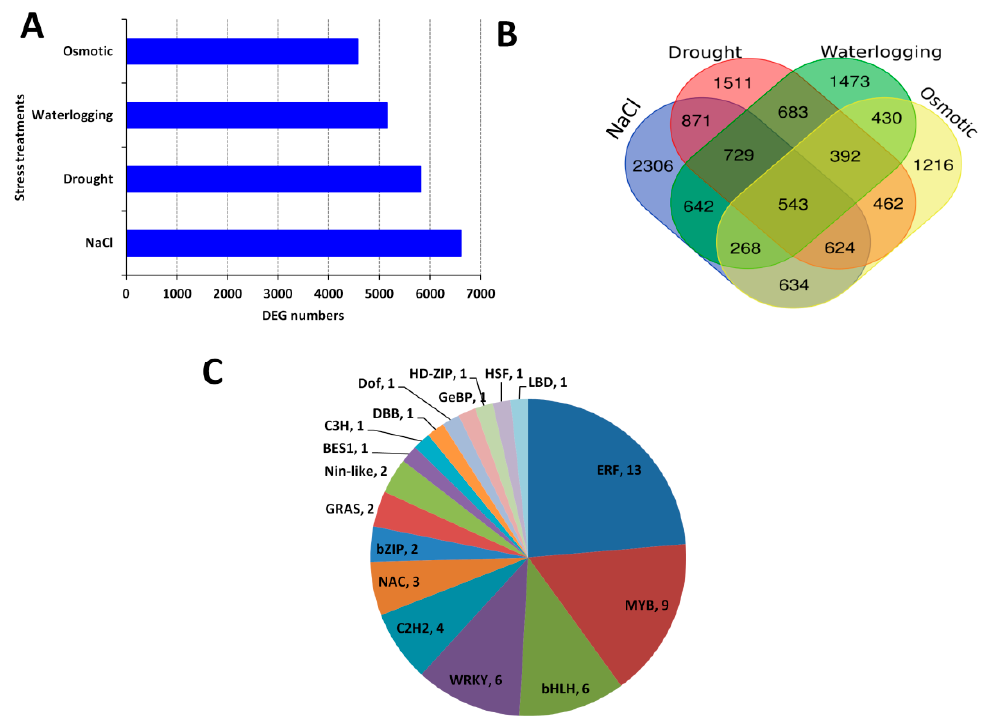
Figure 1. Identification of the core abiotic stress responsive genes (CARG) in sesame. ( A ) Differentially expressed genes detected between control and stress treatments. ( B ) Venn Diagram showing stress specific genes and CARGs. ( C ) Major transcription families enriched in the sesame CARGs.